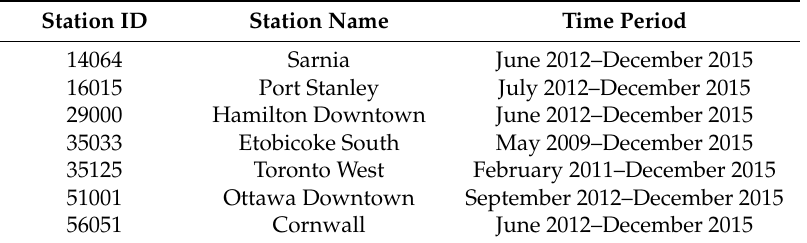
10 of 13 Table 4. Sampling time periods of collocated SHARP 5030 and Tapered Element Oscillating